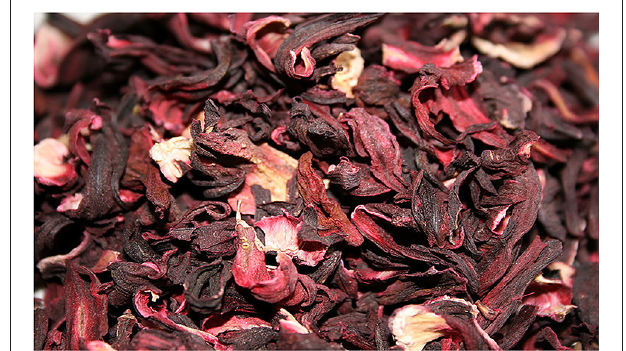
FIGURE 1 | Dried calyces of Roselle ( Hibiscus sabdariffa